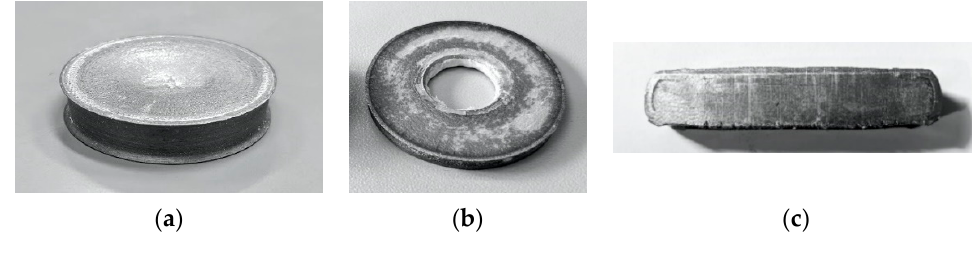
Figure 6. Upset specimens: cylinder ( a ), ring ( b ), and prismatic specimen ( c ). The load curves for all the specimens are represented by monotonically increasing functions of the stroke, which is also typical for other warm and cold upsetting and forging processes (Figure 7). It is evident that the compression force is the highest in ring upsetting. The compression forces for the cylindrical and prismatic specimens are of a comparable magnitude.